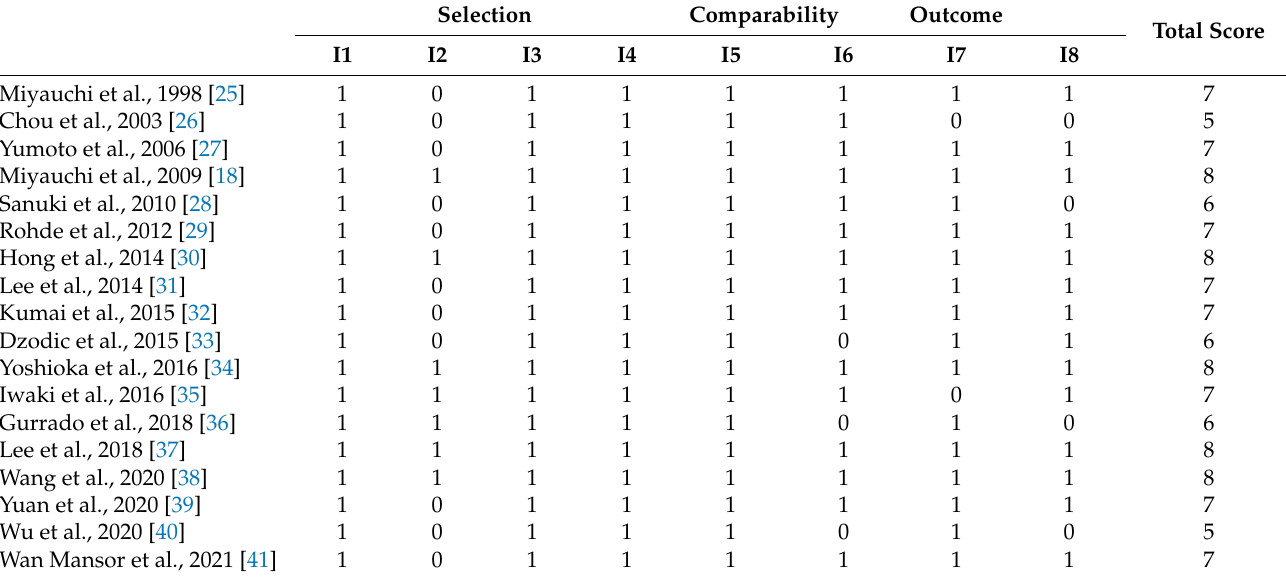
Table 5. Assessments of studies included using the Newcastle–Ottawa